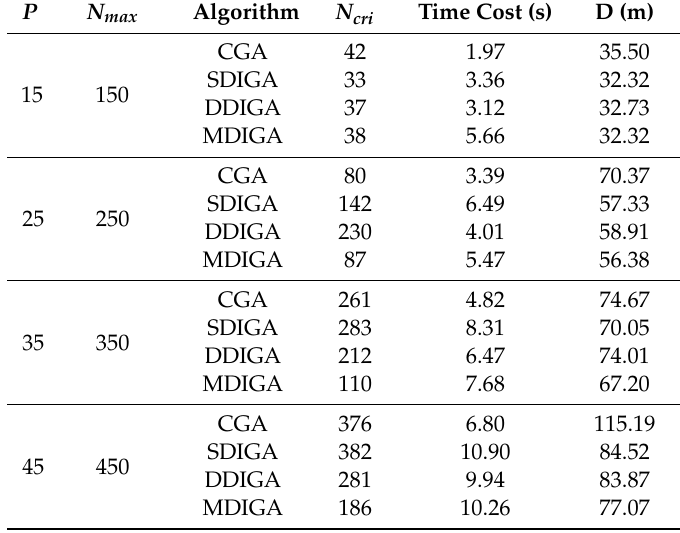
Figure 14. Convergence history of optimal path distance versus iterations for each algorithm: ( a ) P = 15; ( b ) P = 25; ( c ) P = 35; ( d ) P = 45. Table 7. Simulating results of each algorithm with four numbers of planned points.